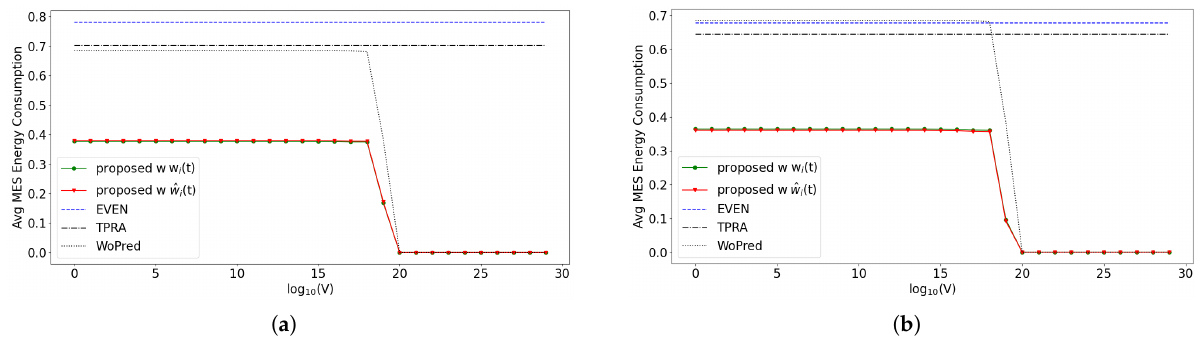
Figure 10. Average energy consumption of a MES with different Vs when N = 6 and N = 9. ( a ) N = 6 classes, and ( b ) N = 9